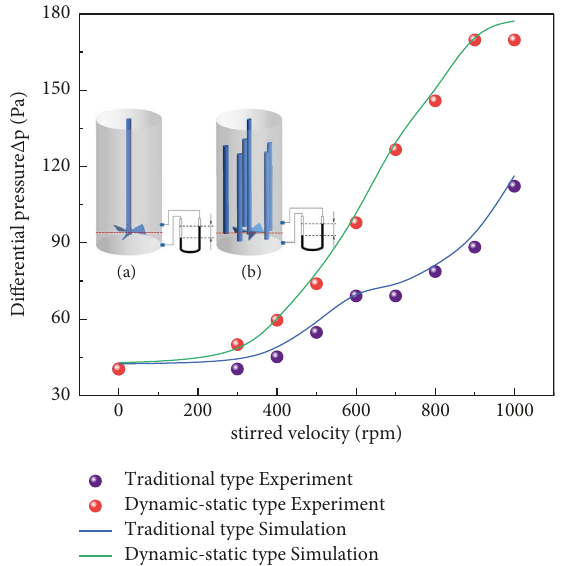
Figure 5: Change of pressure difference under experimental measurement and numerical simulation.